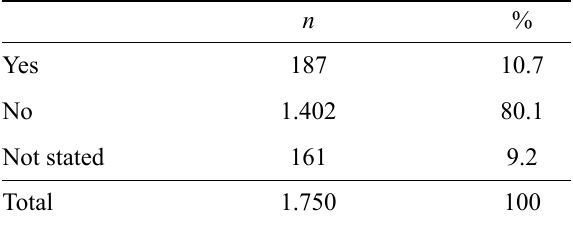
Psychological Assessment Prior to Intake Interview in Patients Referred to